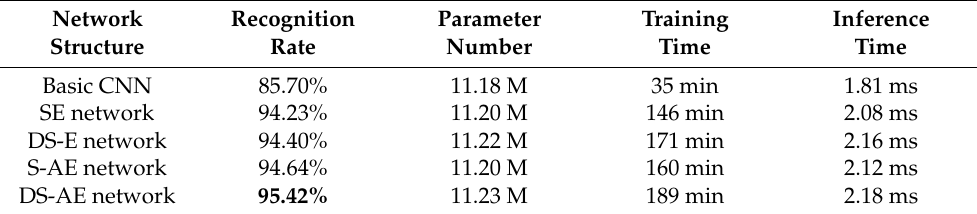
Table 2. Result of the ablation study with 25% of MSTAR training